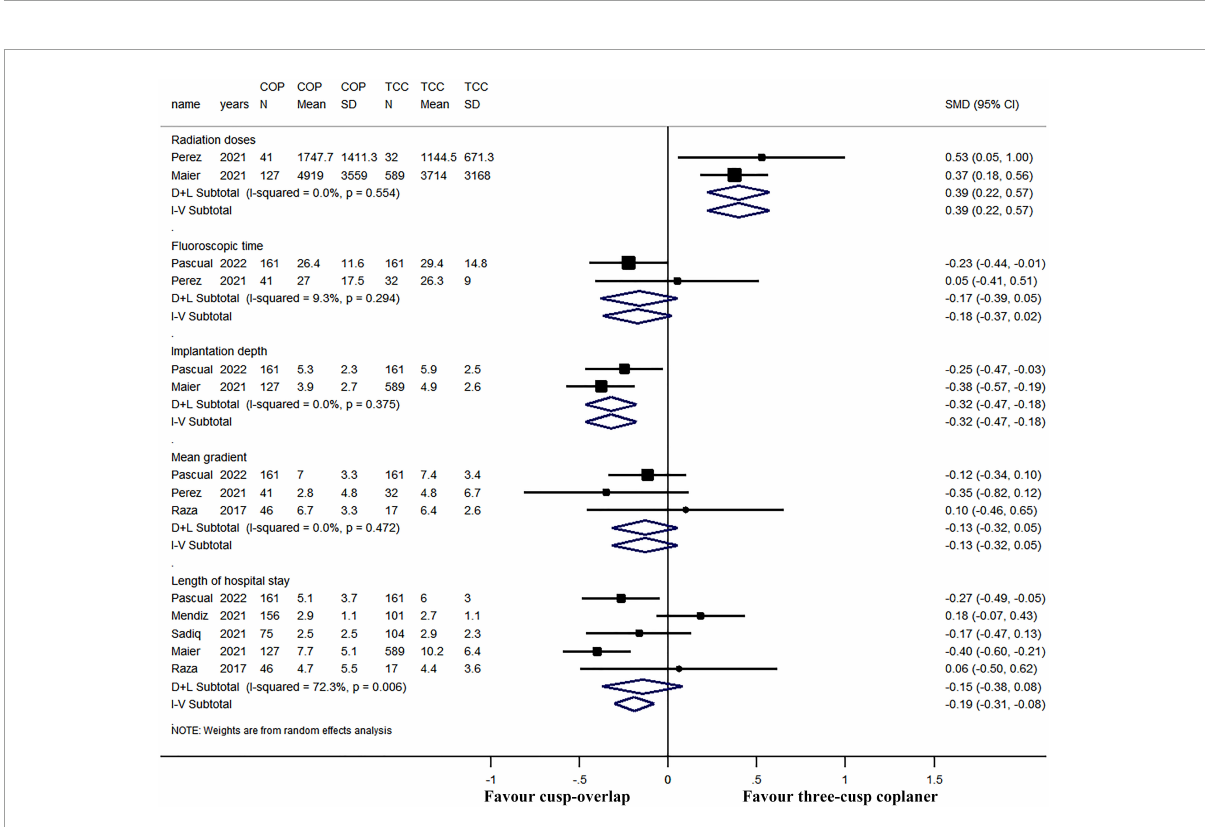
FIGURE5 Meta-analysis of secondary outcomes of interest (continuous variables). Both the random-effects model (D + L) and fixed-effects model (I–V) have been presented in the Forrest plot. Based on heterogeneity examination, radiation doses, fluoroscopic time, implantation depth, and mean gradient were tested using the fixed-effects model, while the length of hospital stay should be compared using a random-effects model. The pooled analyses suggested that a higher implantation depth was achieved by using the COP technique, while radiation doses were higher in the COP group. The bars represented a 95%